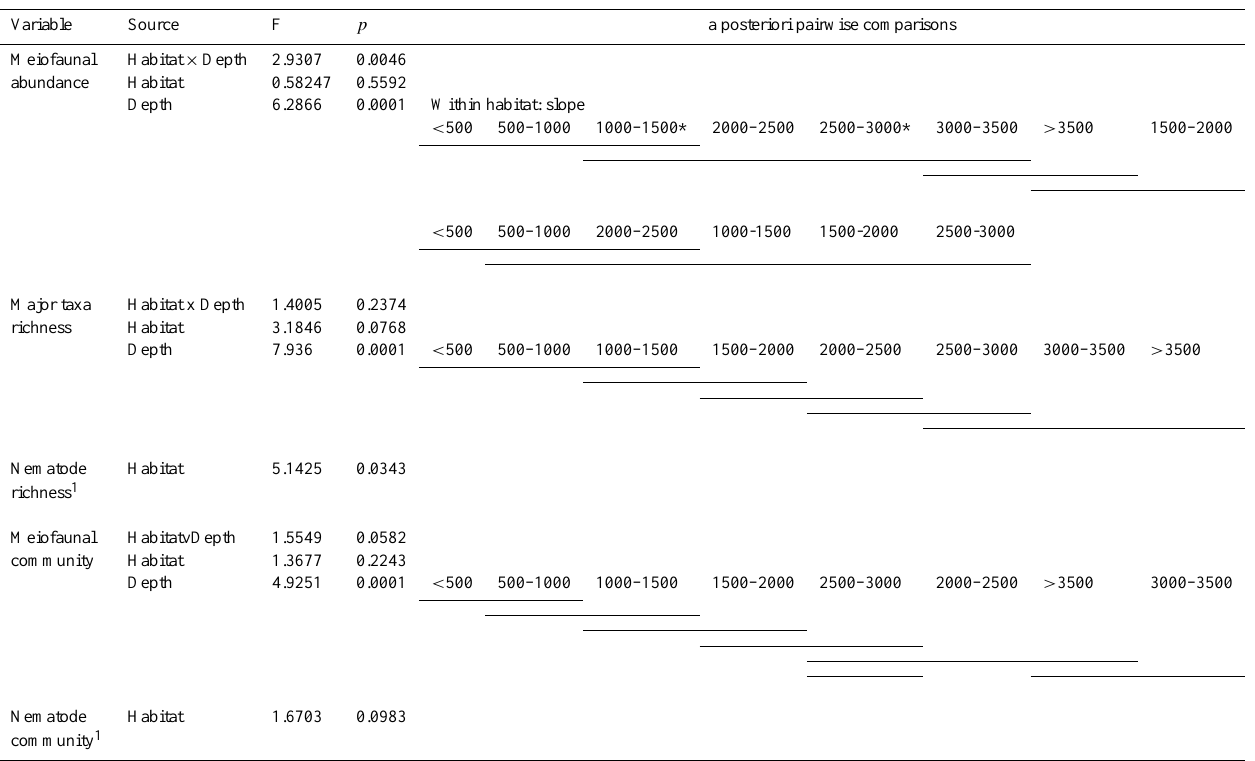
Table 2. PERMANOVA (permutational multivariate analysis of variance) results of the effects of habitat and depth for uni- and multivariate meiofaunal variables. p values were obtained using 9999 permutations of residuals under a reduced model. Where statistical significant differences were indicated pairwise comparisons were done. Depth ranges with common underline are not significantly different at the 95% significance